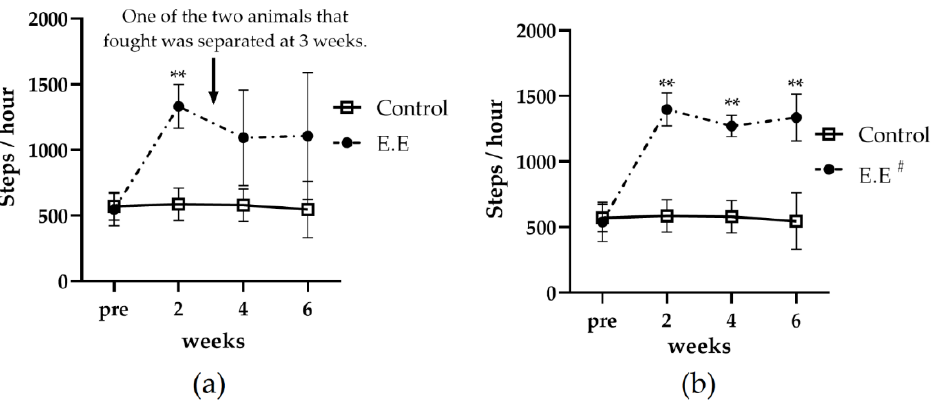
Figure 3. Steps per hour measurement at 2-week intervals, including before the environmental change of placing them into the cages (pre) for a total of 6 weeks when the separated fighting dog was ( a ) included and ( b ) not included. E.E: Environmental enrichment group. ** p < 0.01 vs. control group. # Except for the one dog that fought.